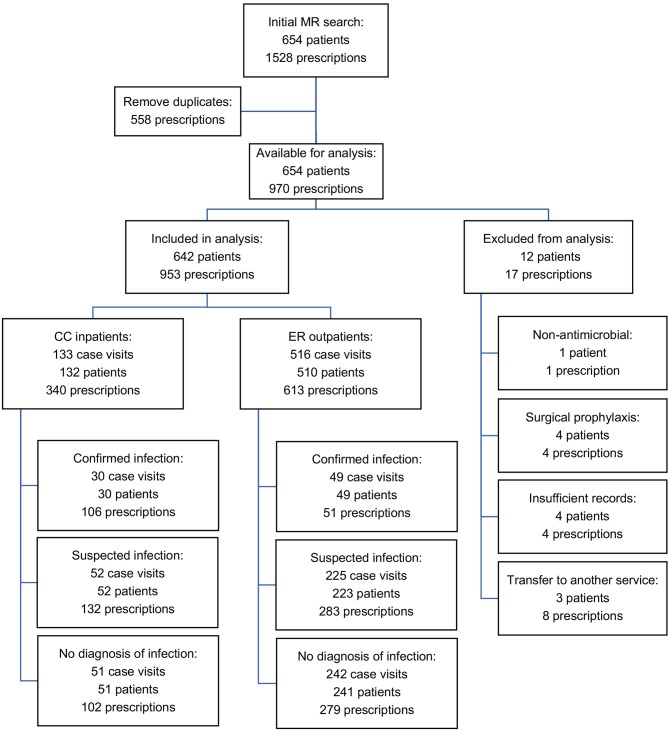
Flow chart of curation and analysis of medical records and prescriptions included in the final dataset.